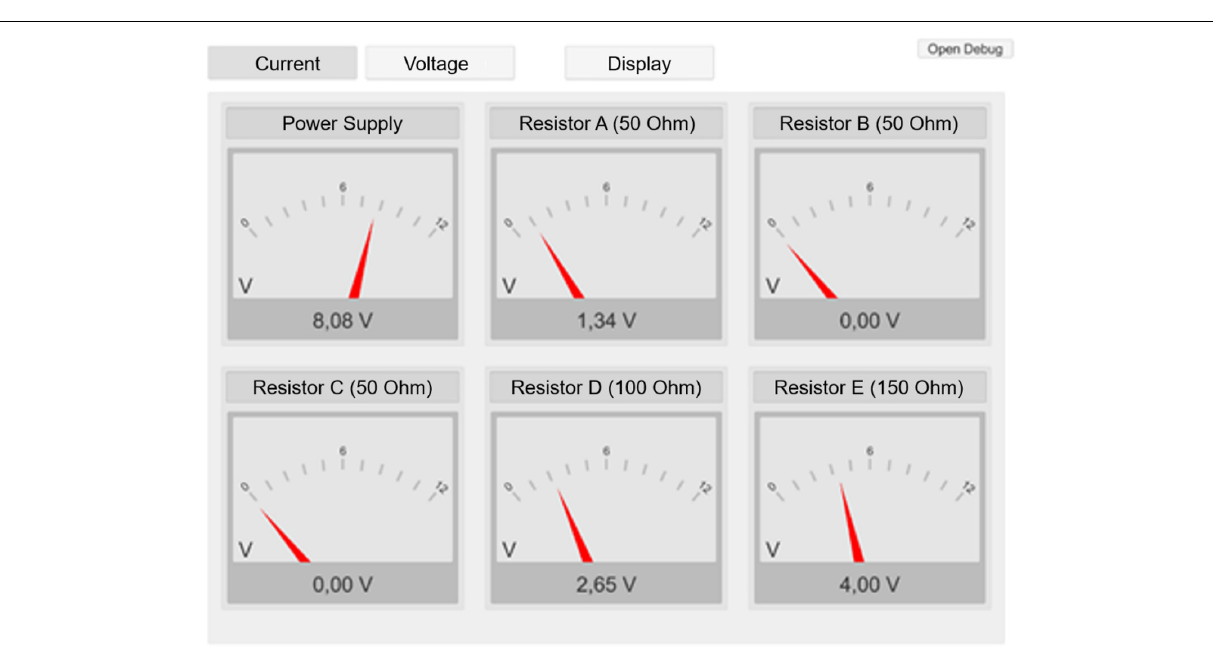
FIGURE 3 | Screenshot of the matrix visualization as presented on the tablet (translated for this